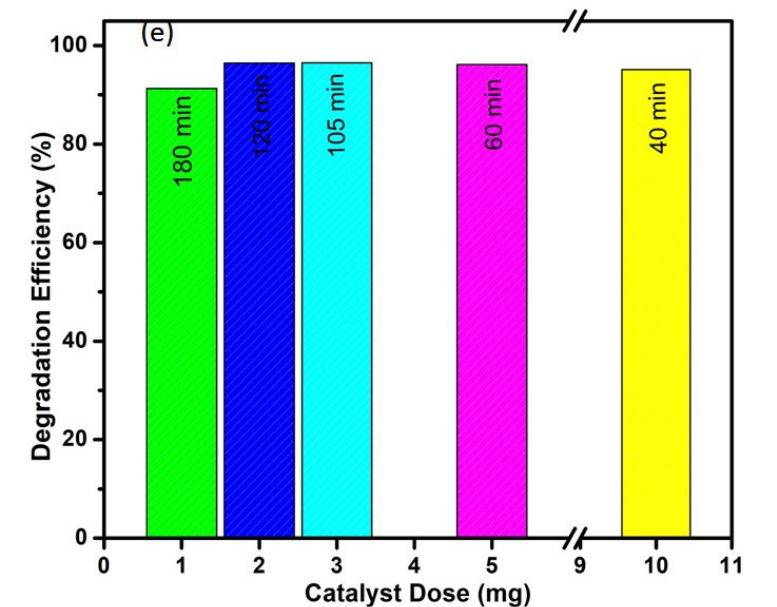
Figure 7. Effect of catalyst dose ( a ) 1 mg, ( b ) 3 mg, ( c ) 5 mg, and ( d ) 10 mg and ( e ) comparison among the efficiencies of all concentrations on degradation of CV dye.